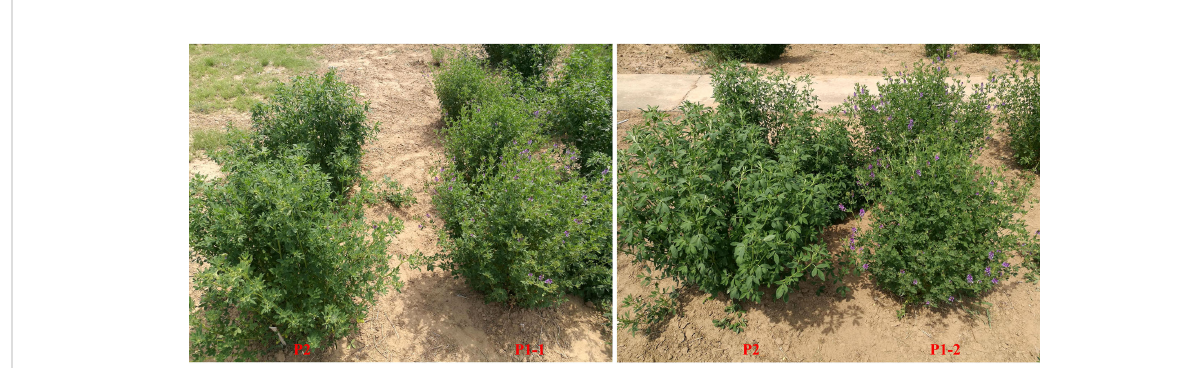
FIGURE 1 The phenotypic difference between the parents P1-1, P1-2 and P2 for fl owering